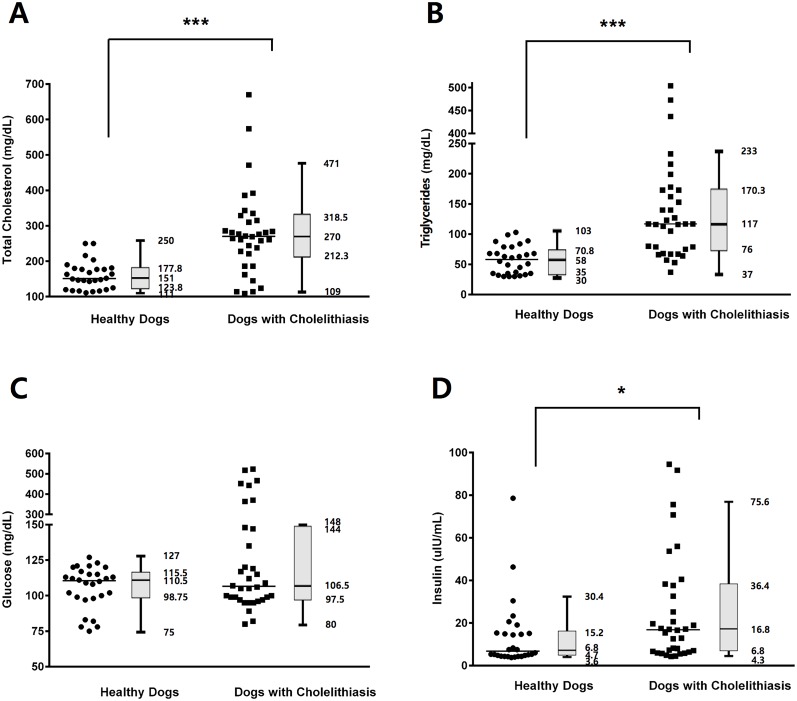
The results of biochemical and hormonal analyses.Serum (A) total cholesterol, (B) triglycerides, and (D) insulin concentrations were significantly higher in dogs with cholelithiasis (n = 34) compared with those in the healthy dogs (n = 28), but (C) glucose levels were not significantly different between the two groups. Horizontal bars in scatter plots indicate median values. *p < 0.05, ***p < 0.001 between groups.